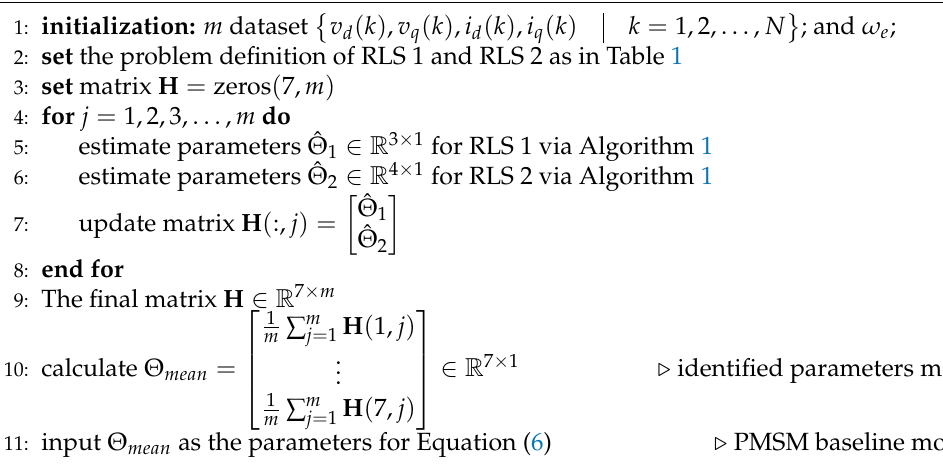
Algorithm 2 Baseline model identification